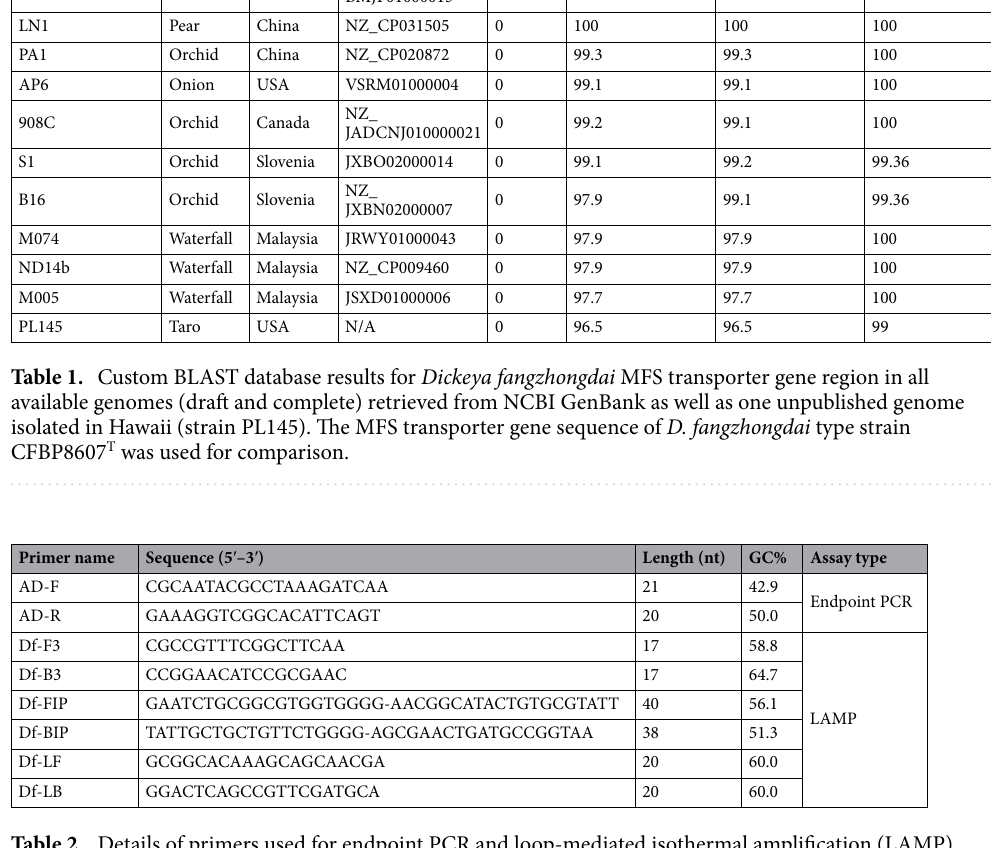
Table 2. Details of primers used for endpoint PCR and loop-mediated isothermal amplification (LAMP) assays for detection of Dickeya fangzhongdai . The MFS transporter gene region of D. fangzhongdai was used to design these